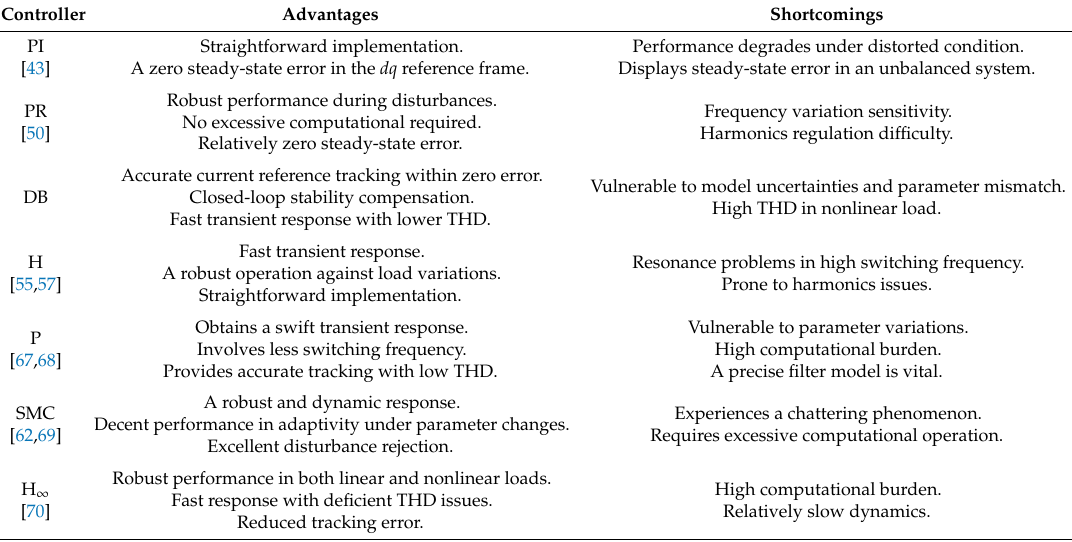
Table 1. The advantages and shortcomings of the inner-loop controllers’ scheme.